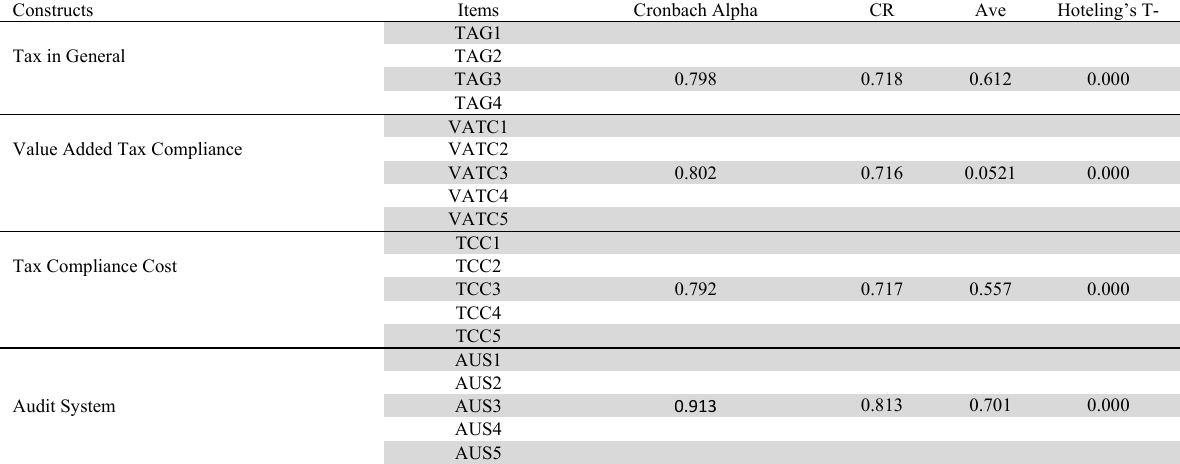
Fornel Larker Scale to Examine the Discriminant Validity TAG VAT TCC